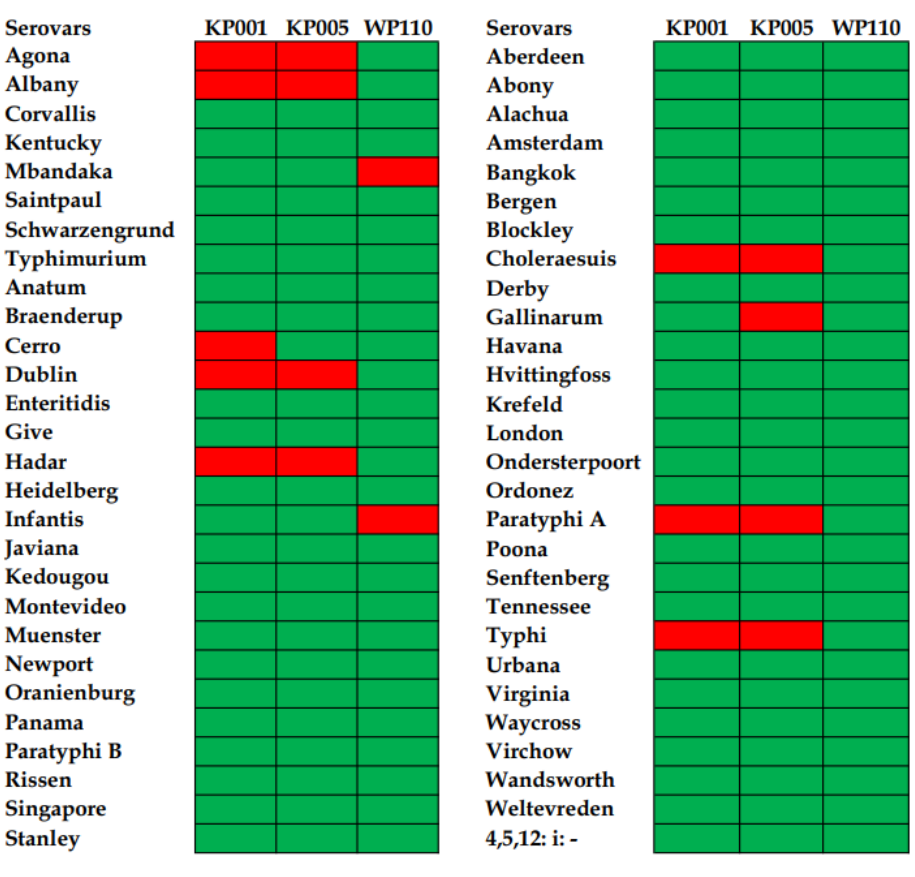
Figure 1. Heatmap representation of lysis profiles of three Salmonella phages tested on 56 Salmonella serovars. Green areas indicate lysis, and red areas indicate no lysis. Table 1. Efficacy of a phage cocktail on Salmonella reference